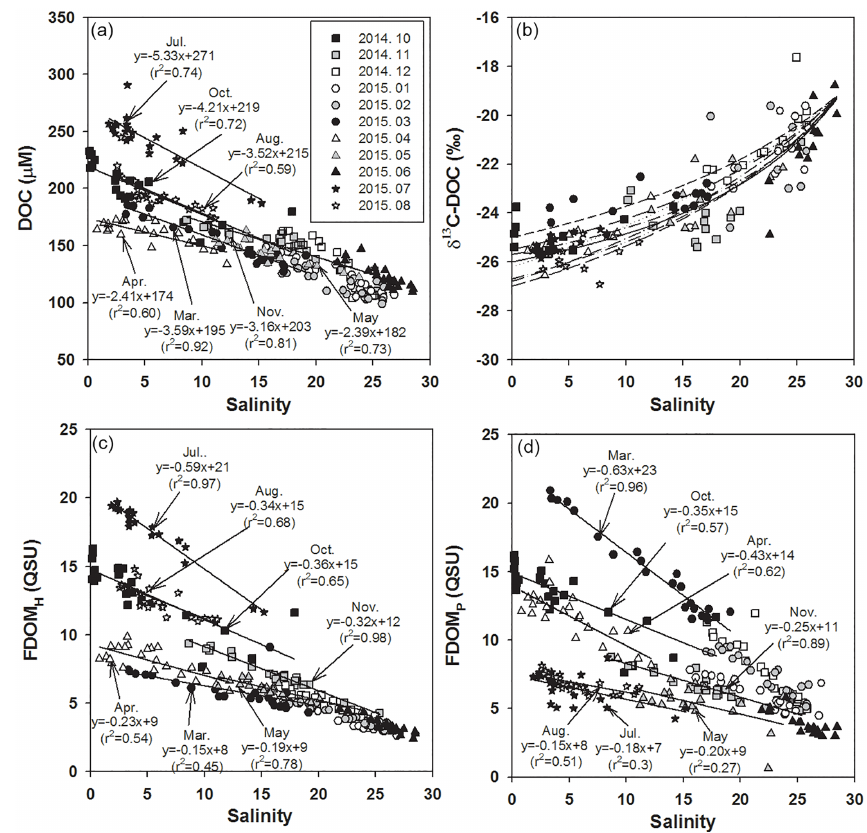
Figure 2. Salinities versus the concentrations of (a) DOC, (b) δ 13 C-DOC, (c) FDOM H , and (d) FDOM P . The values for the regression lines are excluded for high-salinity periods (>20), including December, January, February, and June, which have large uncertainties in extrapolation. The solid curve (b) is the average conservative mixing line for the two end-member mixing equations. The dotted lines represent the monthly changes in mixing lines for the different monthly end-member